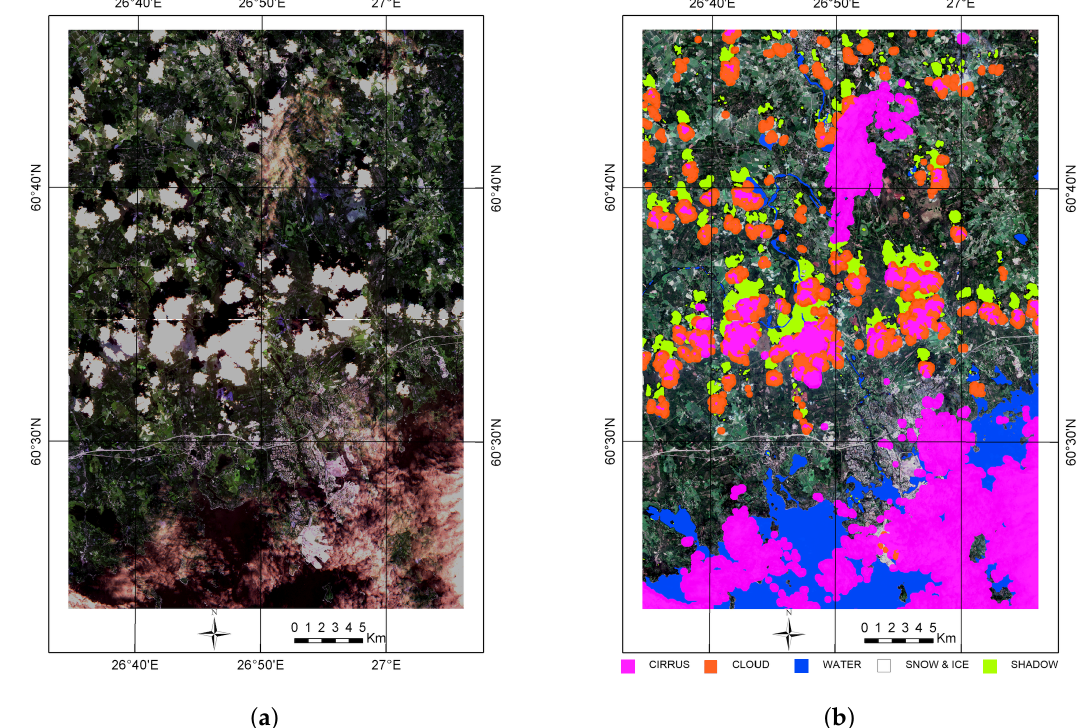
Figure 9. Extract of Sentinel-2 image of 29 June 2016, Southern Finland. ( a ) Natural colour image from 0.672 µ m, 0.555 µ m and 0.490 µ m reflectance. High clouds on land and sea areas are shown in magenta, low clouds in orange. ( b ) Cloud and shadow detection result. ( a ) Natural colour image; ( b ) Cloud/shadow